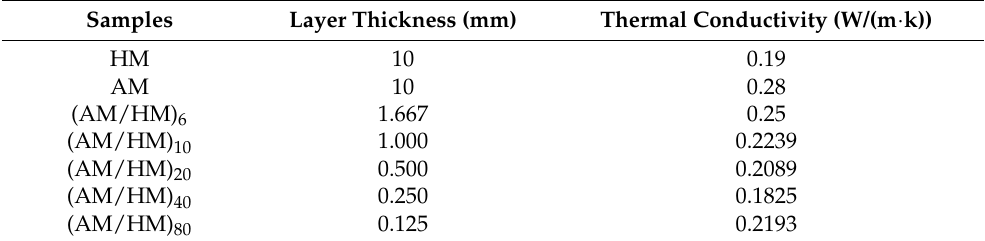
Table 1. Layer thickness and thermal conductivity of the (AM/HM) n